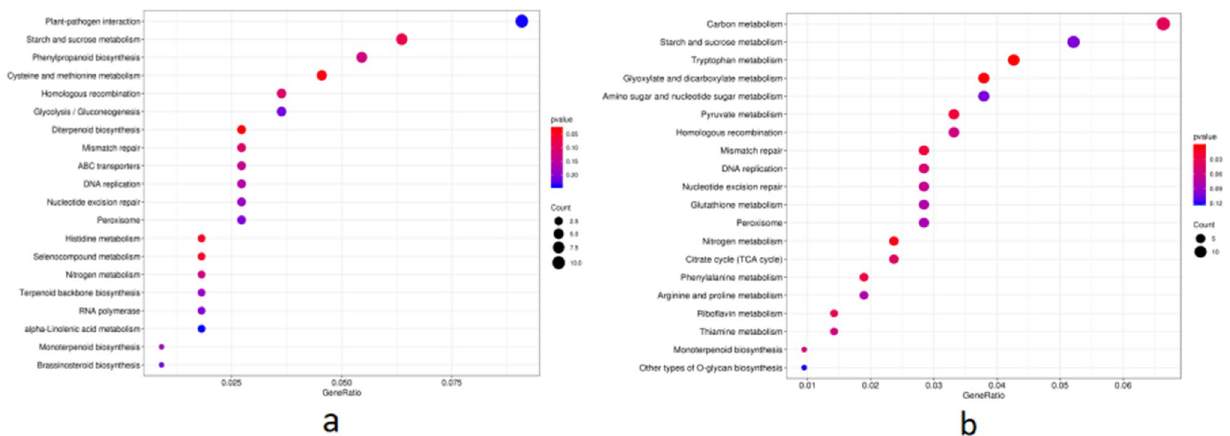
Figure 7. KEGG enrichment of different expression genes. ( a ) WT vs AS KEGG pathway enrichment; ( b ) WT vs OE KEGG pathway